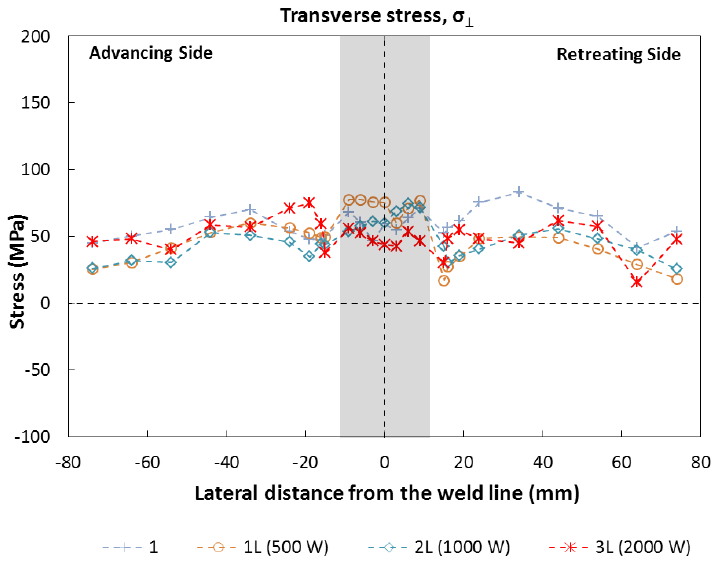
Figure 15. Transverse residual stresses along the